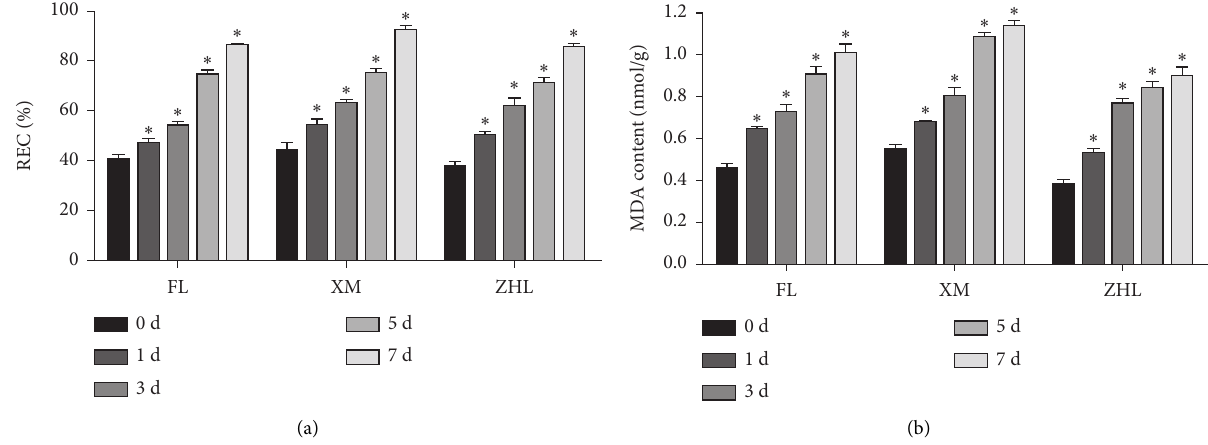
Figure 2: The changes of REC (a) and MDA content (b) of the annual branches of the three varieties of pitaya with cold treatment. “ ∗ ” indicates the changes of moisture content and chlorophyll content with a significant difference at p < 0 . 05 compared with the control